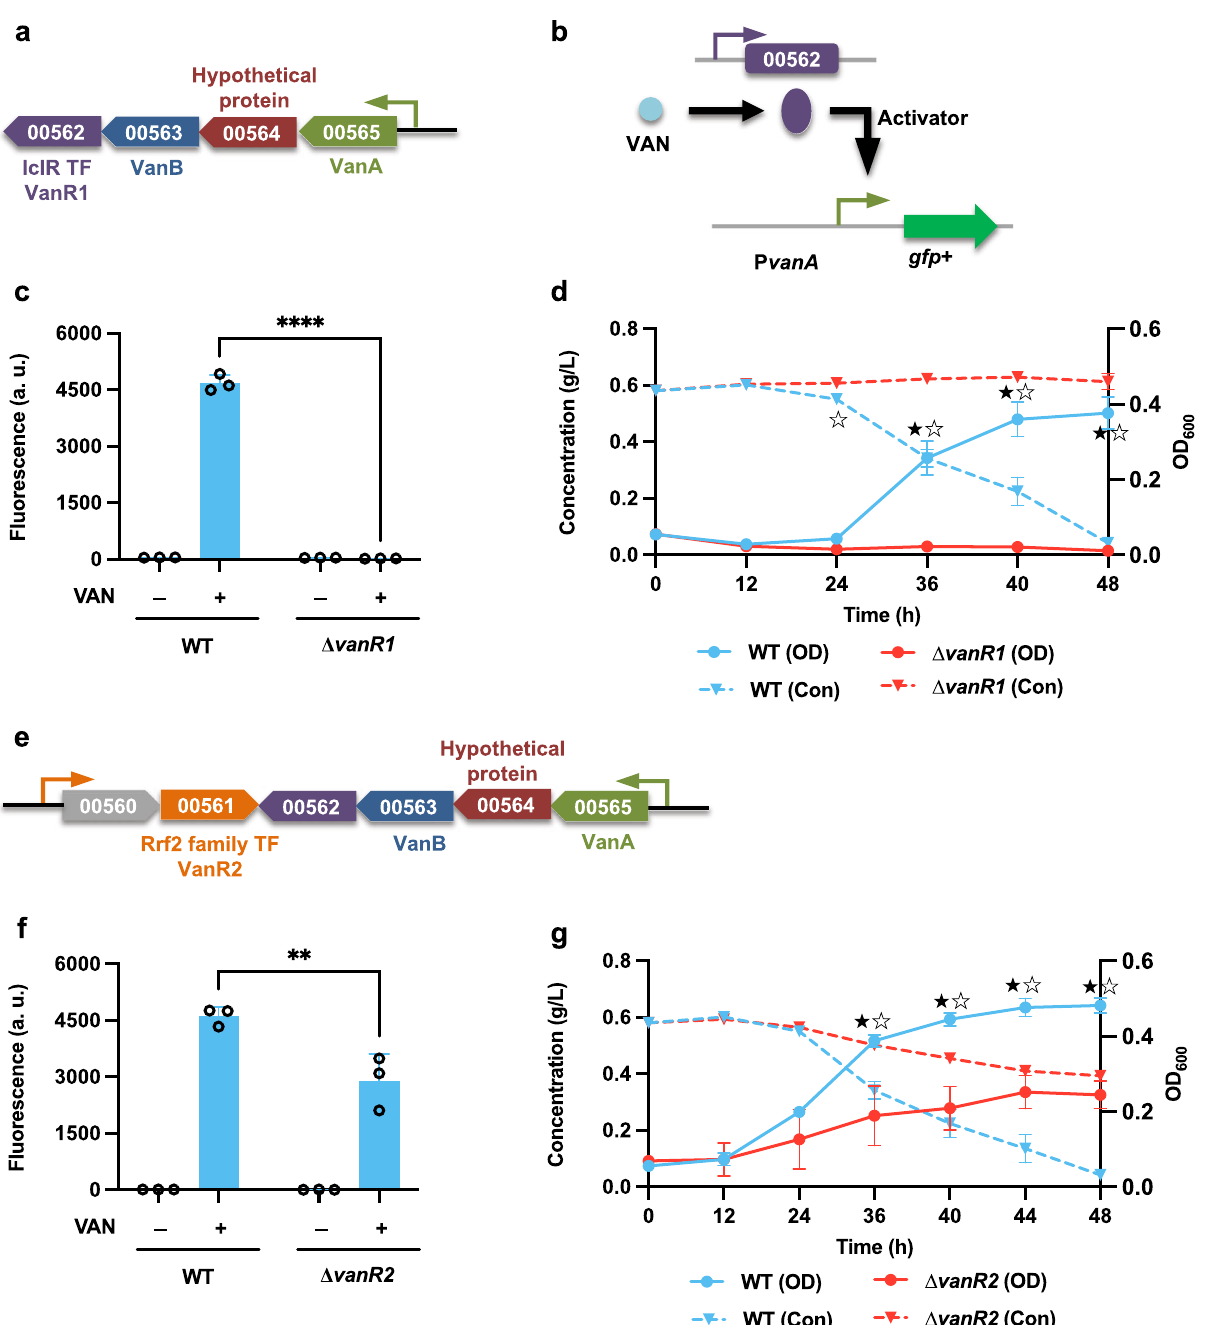
Fig. 4 The transcription factor vanR1 (LPD00562) activates the degradation of vanillate. a , e The vanillate degradation operon in R. opacus is adjacent to two transcription factors, vanR1 (LPD00562) and vanR2 (LPD00561). Promoters are represented as small arrows, and genes are shown with LPD gene numbers from the NCBI database (Refseq, CP003949.1). For the full annotations of the pathway genes, see Supplementary Table 1. b The proposed working model for vanR1 . c , f Analysis of the function of the proposed transcription factors. The construct P vanA -GFP + was expressed in WT and in the corresponding TF deletion mutant strains. The normalized fl uorescence of the WT, Δ vanR1 , and Δ vanR2 was measured with and without supplemental vanillate (VAN). d , g Comparison of the cell growth (OD) and vanillate consumption (Con) between the WT and the two TF deletion mutant strains Δ vanR1 and Δ vanR2 when fed 0.6 g/L VAN as the sole carbon source. For all fl uorescence assays, cell cultures contained 1 g/L glucose with ( + ) or without ( − ) 0.3 g/L VAN as the carbon source; all the fl uorescence values were determined in the early stationary phase and normalized to OD 600 . Unpaired two-tailed t test was used to compare the variation in the change of fl uorescence of the mutants treated with VAN against that of the WT control (**, P < 0.0021; ****, P < 0.0001). To assess cell growth and aromatic consumption, the variations in the changes of cell density (OD) and aromatic concentration (Con) of the mutants were compared against those of the WT control ( ★ , P < 0.05 for OD; ☆ , P < 0.05 for Con; two-tailed mixed model ANOVA with Sidak ’ s multiple comparisons). All values represent the mean of triplicate cultures, with error bars depicting the standard deviation from that mean.